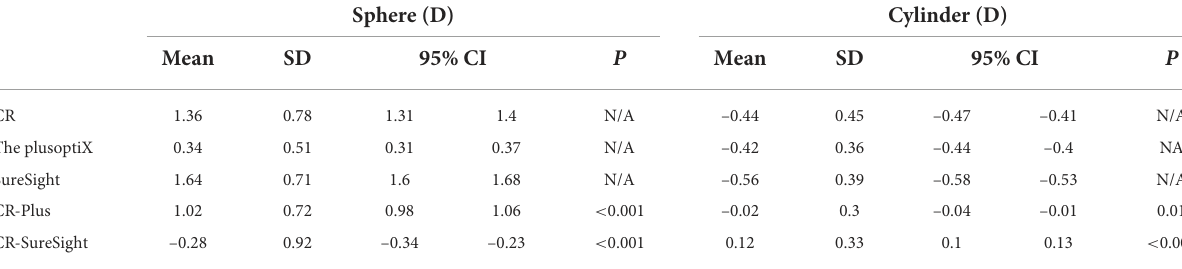
TABLE 2 Comparison of SureSight, PlusoptiX, and cycloplegic retinoscopy in 1,159 children.